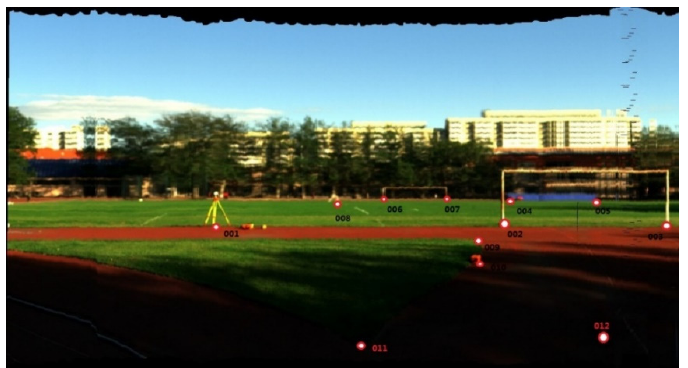
Figure 5. The raw image acquired by GBC with the side-scanning mode. (it includes geometric distortions).